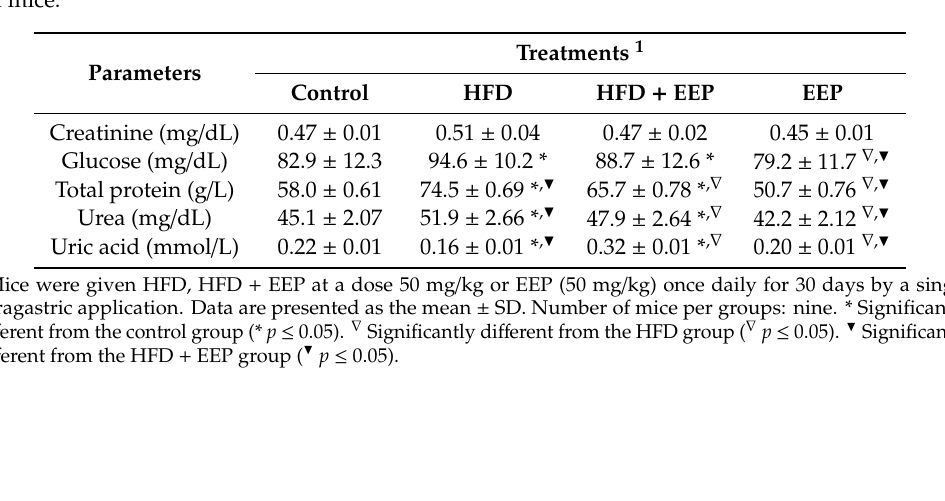
Figure 8. Effect of ethanol extract of propolis on cardioprotective index (CPI). Mice were given HFD, HFD + EEP at a dose 50 mg / kg or EEP (50 mg / kg) once daily for 30 days by a single intragastric